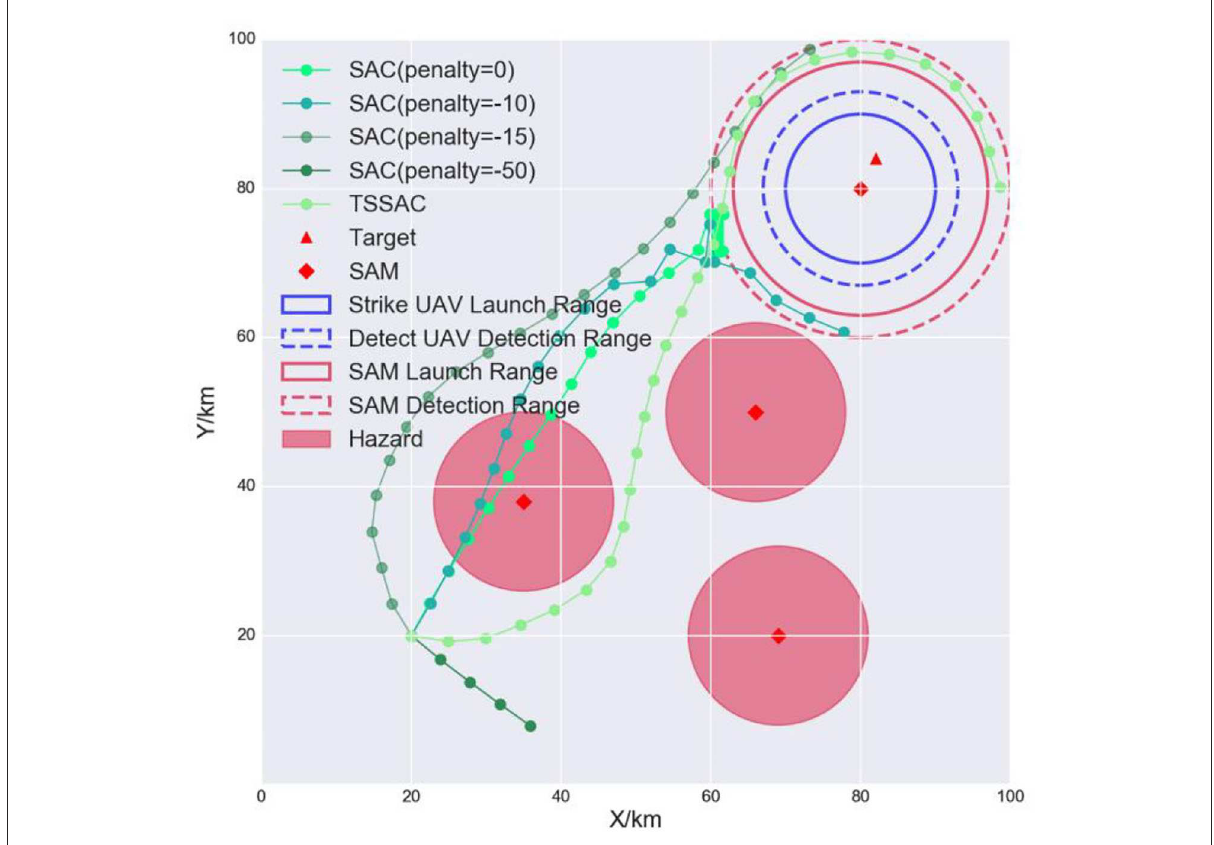
FIGURE12 Safety analysis of the UAV